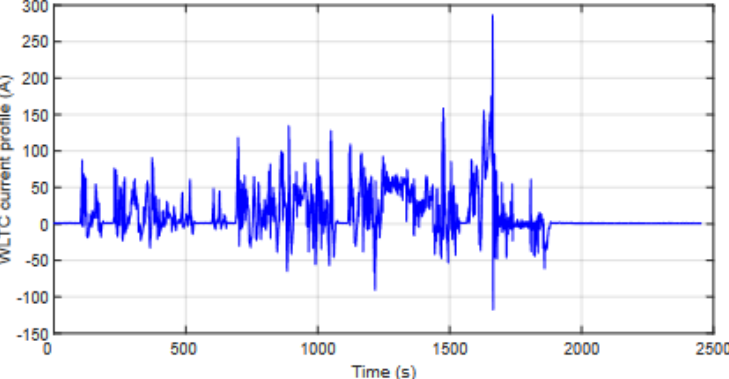
Figure 10. WLTC battery current profile from data recorded on chassis dynamometer.